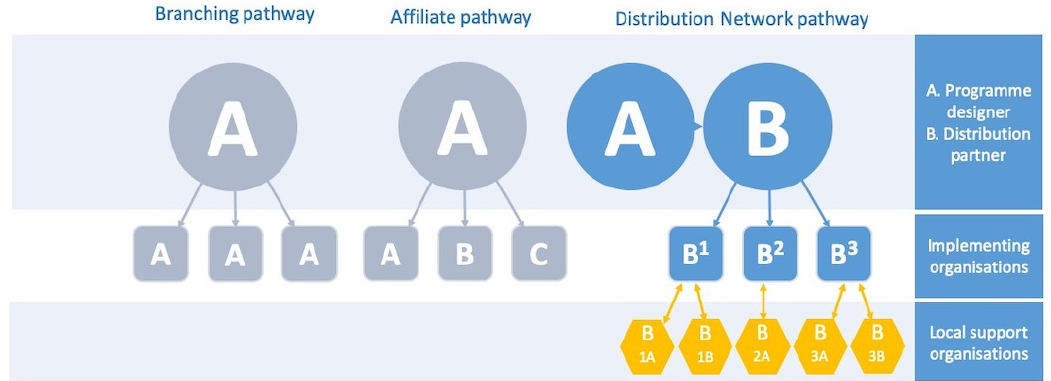
Figure 1. Branching, Affiliate, and Distribution Network Pathway Structures with an extension to local support organiza- tions, as informed by the present study.